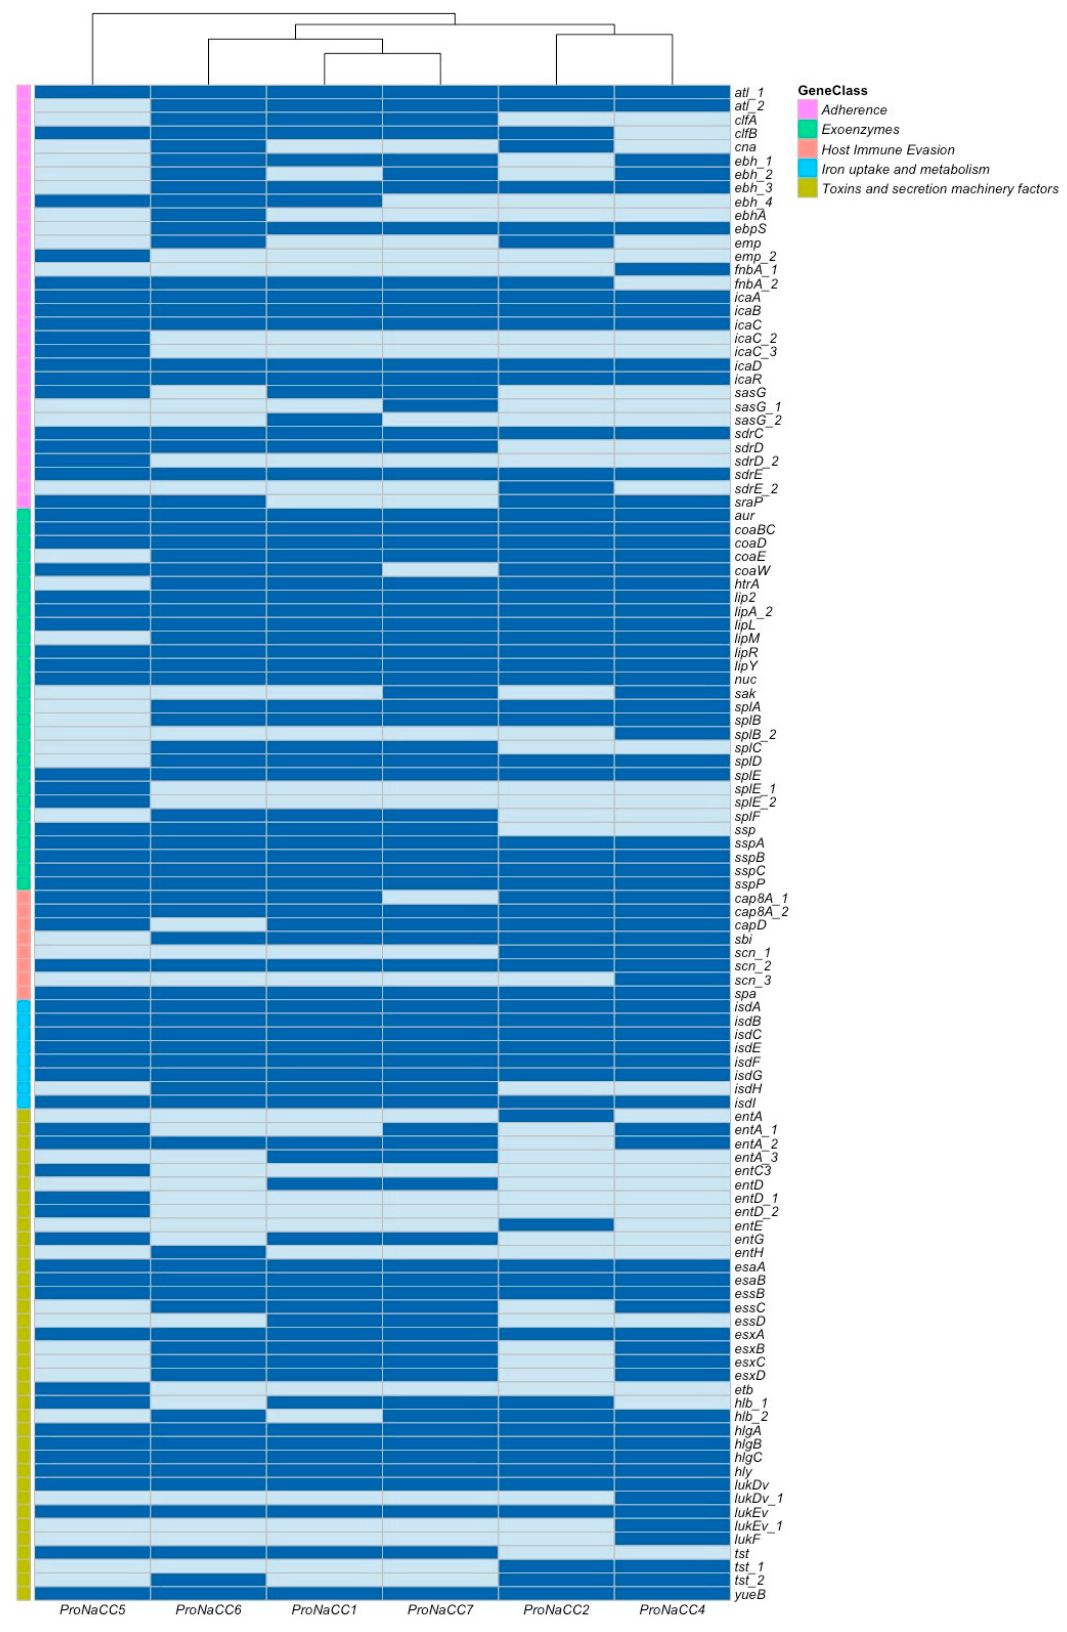
Figure 1. Heat map showing the profile of virulence factors (VFs) genes for the five enterotoxigenic S. aureus strains (dark blue: sequence detected; light blue: sequence not detected).